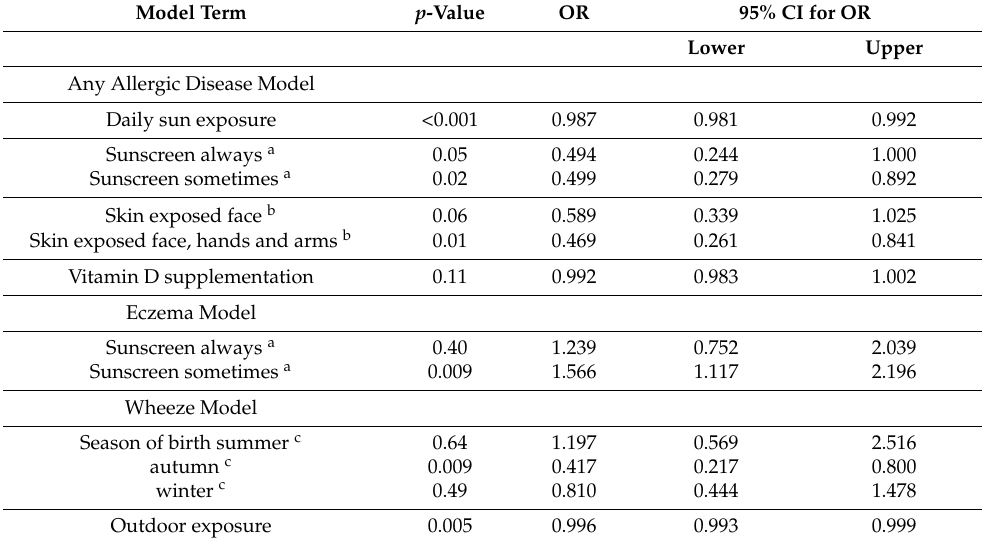
Table 4. Generalised Linear Mixed Models (binary logit link function) for outcomes any allergic disease, eczema and